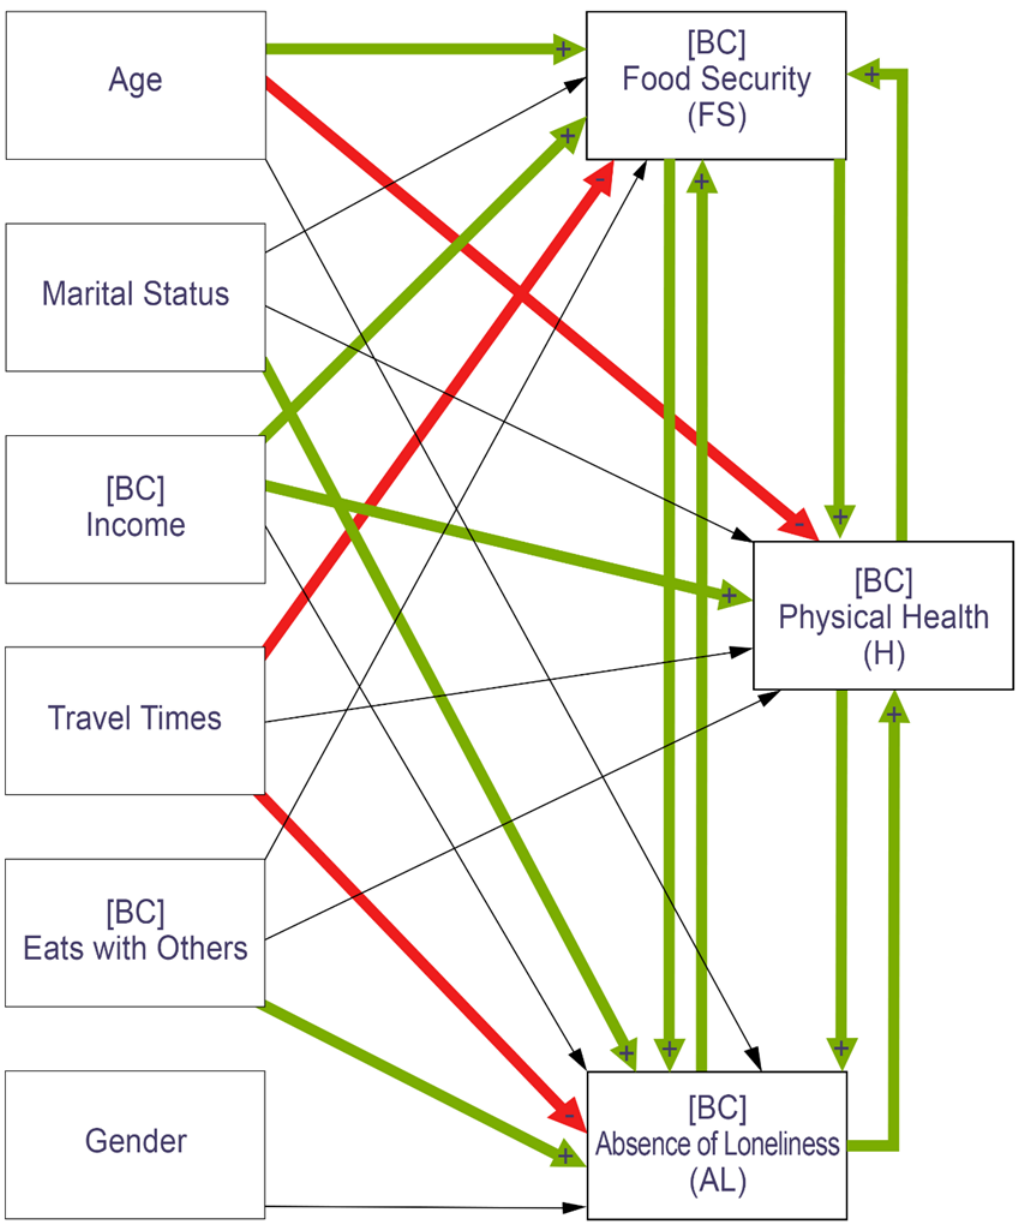
Figure 1. Path analysis for before the pandemic. Thick lines represent significance at α = 0.05. Thin lines represent insignificance. Green represents positive relationships and red negative relationships.